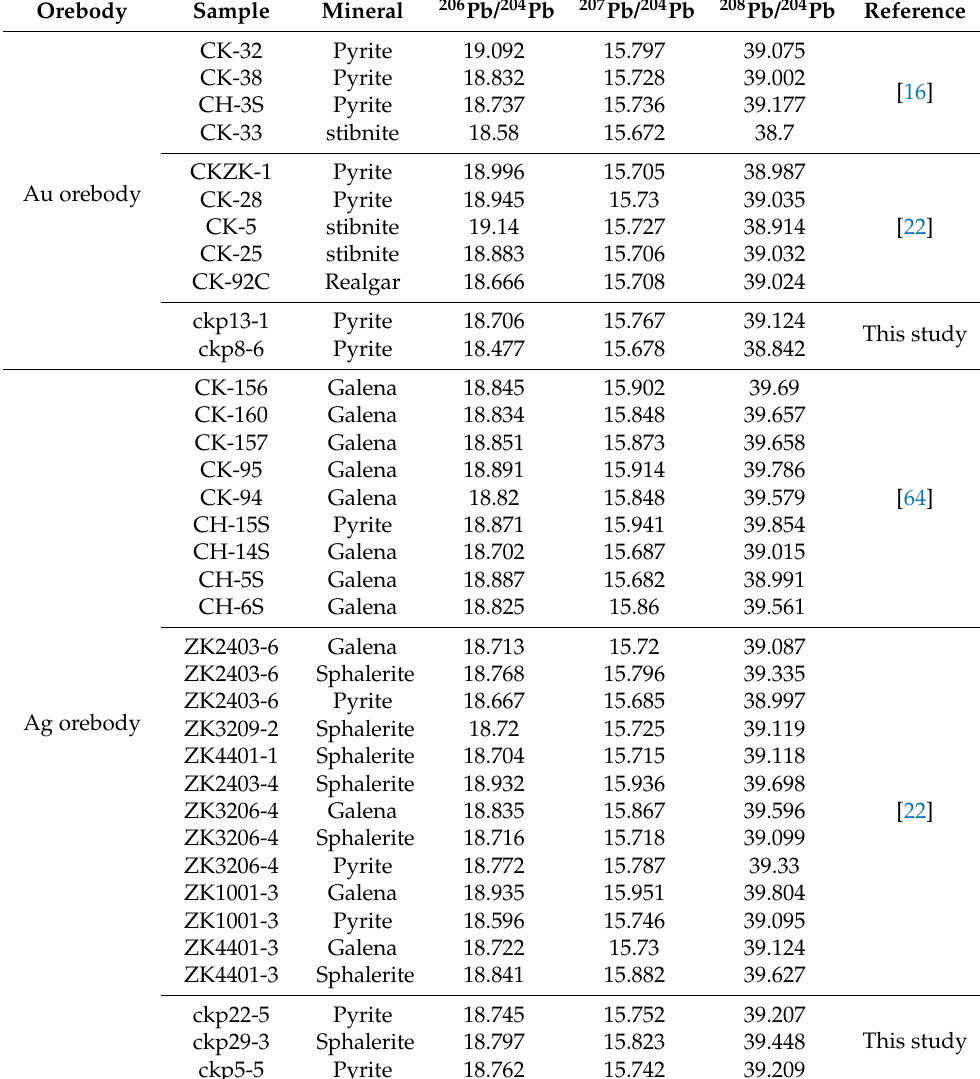
Table 5. Pb isotope data of the ores from the Changkeng–Fuwan Au-Ag